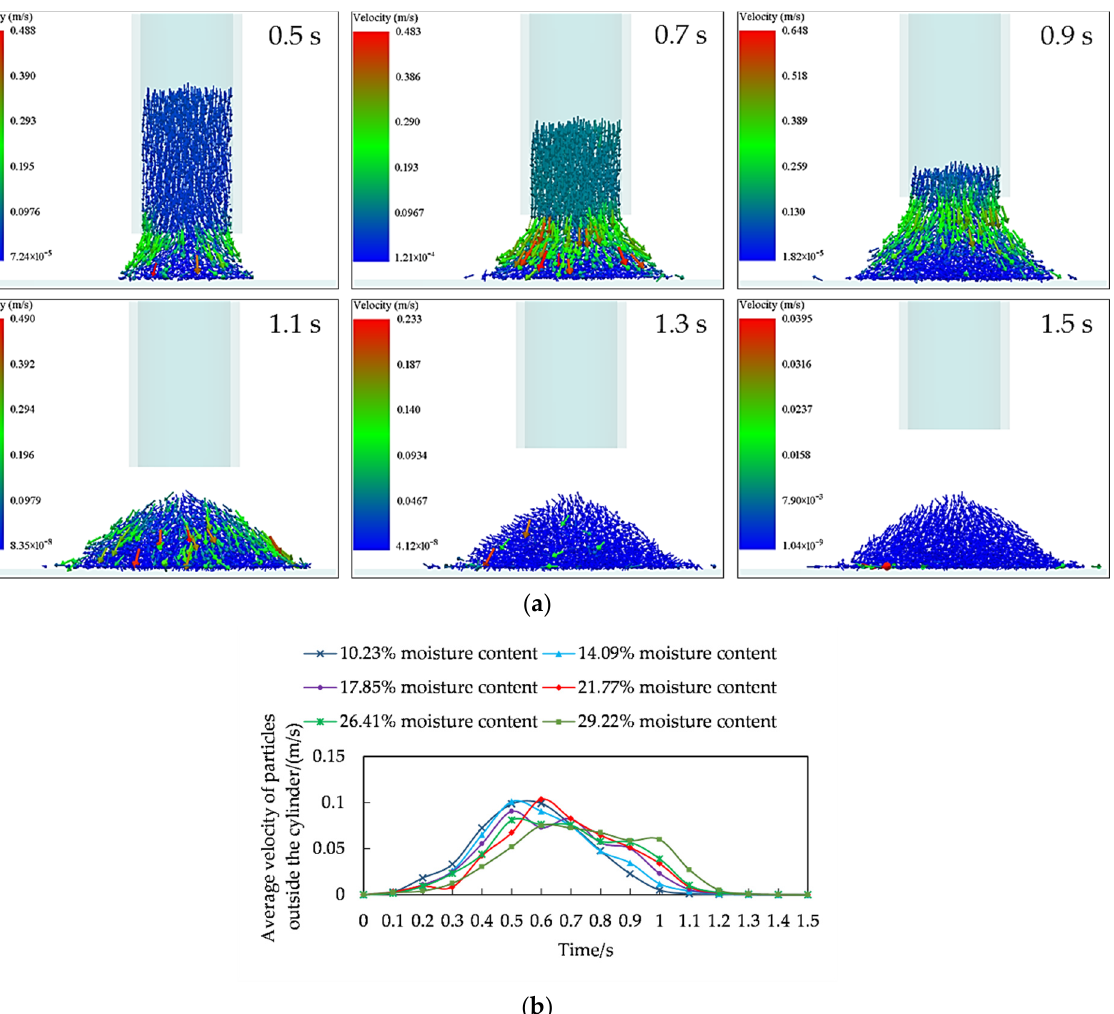
Figure 2. Characteristics of rice seeds accumulation velocity with the moisture content of 29.22%: ( a ) velocity distribution in the accumulation process; ( b ) average velocity of the rice seeds outside the cylinder at different moments.